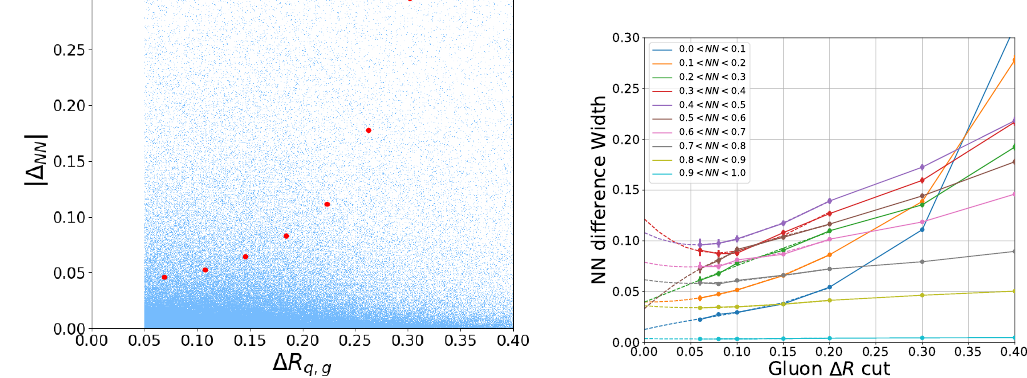
Figure 9 . Same distributions as in (cid:12)gure 6. Events where the gluon and its nearest quark are in the same pixel have been removed from the